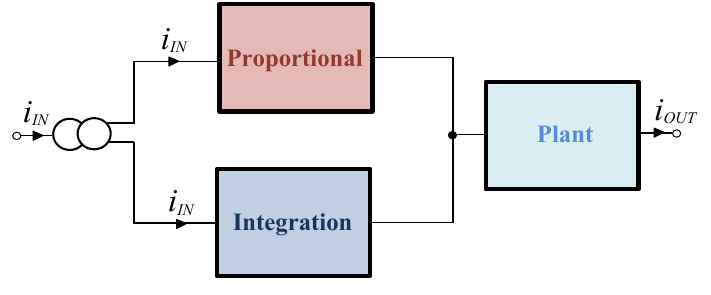
Figure 16. Functional Block Diagram of the realized